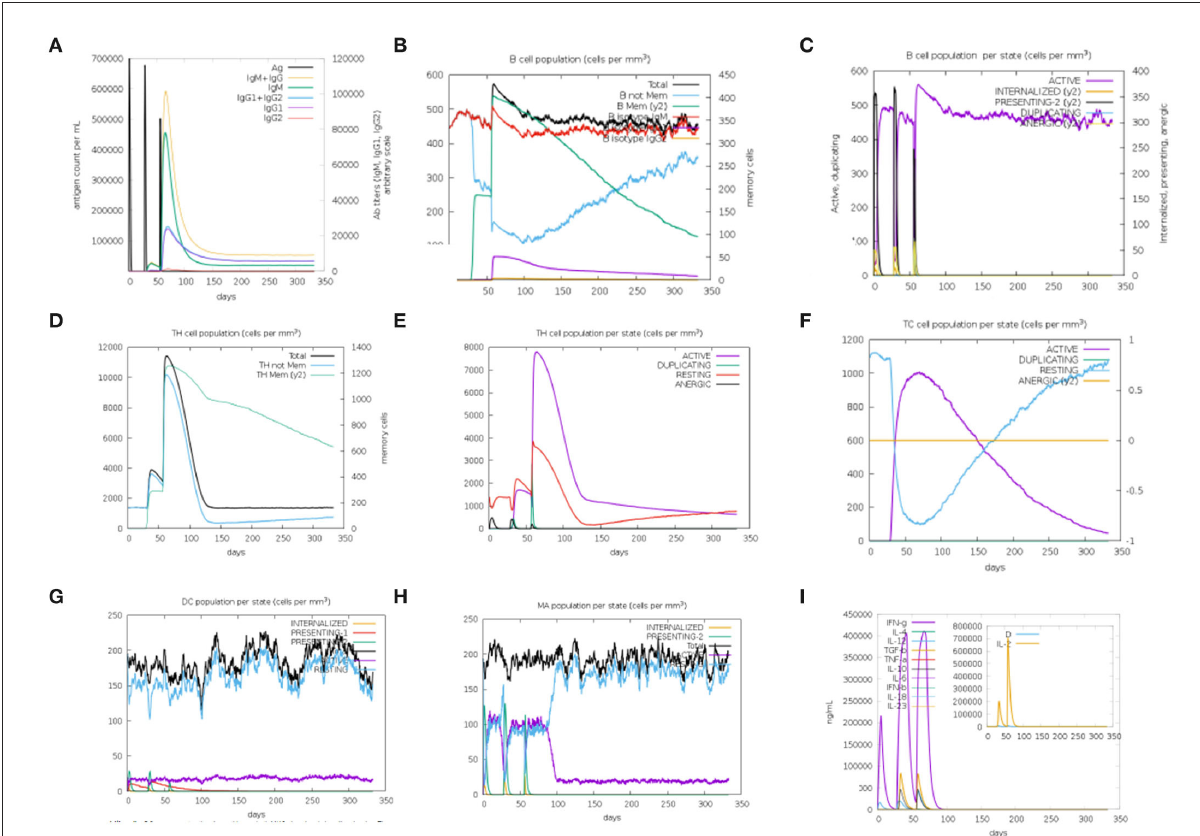
FIGURE9 Molecular dynamics simulation, normal mode analysis (NMA), and receptor–ligand interactions: (A) vaccine-TLR-3 docked complex using the Cluspro server, (B) deformability graph, (C) eigenvalue of the vaccine-TLR-3 complex, (D) B-factor graph, (E) covariance matrix, (F) elastic network model using the iMOD server, and (G) receptor–ligand interaction using the PDBsum web